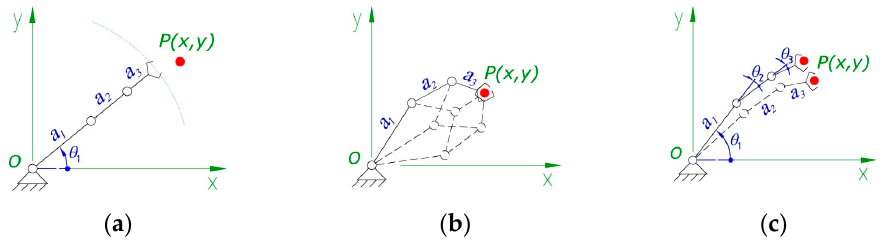
Figure 1. Problematic configurations in solving inverse kinematics for a planar robot with 3 DOF. Incorrectly defined solutions with respect to ( a ) existence, ( b ) uniqueness, and ( c ) stability.